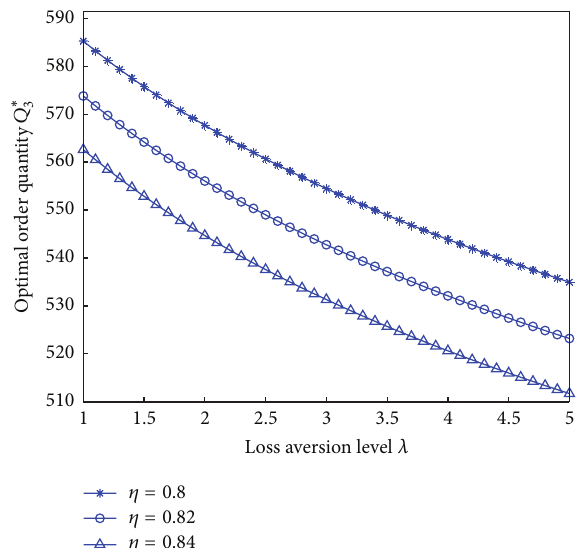
Figure 4: Plot of the optimal order quantity 𝑄 ∗ 3 with 𝜆 under different values of 𝜂 .